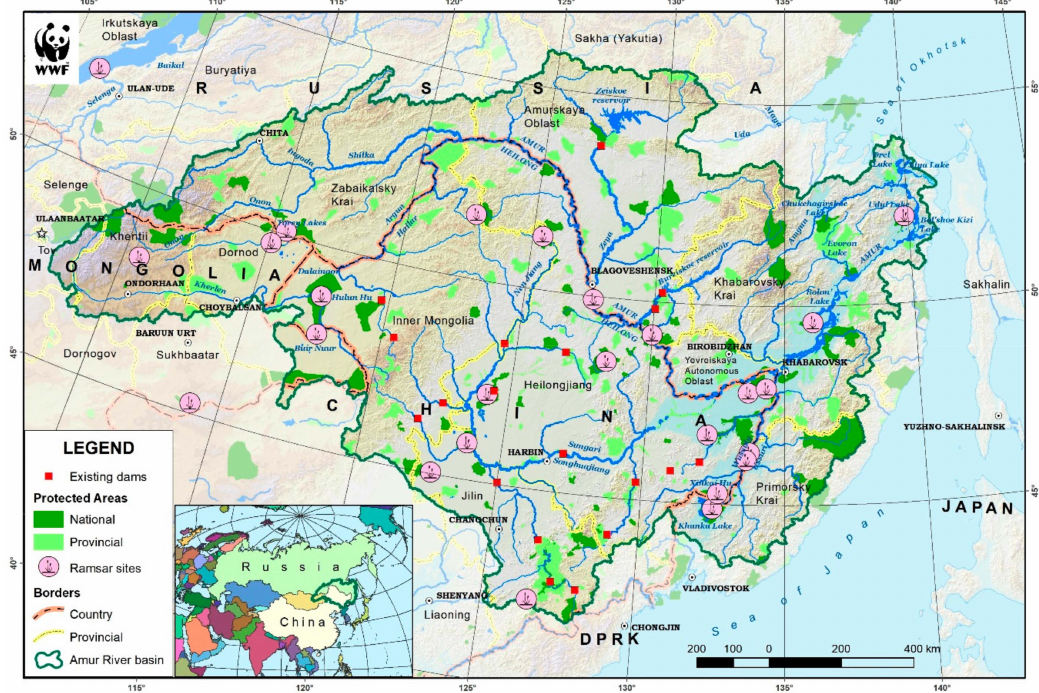
Figure 1. The Amur River basin and its protected areas. ©